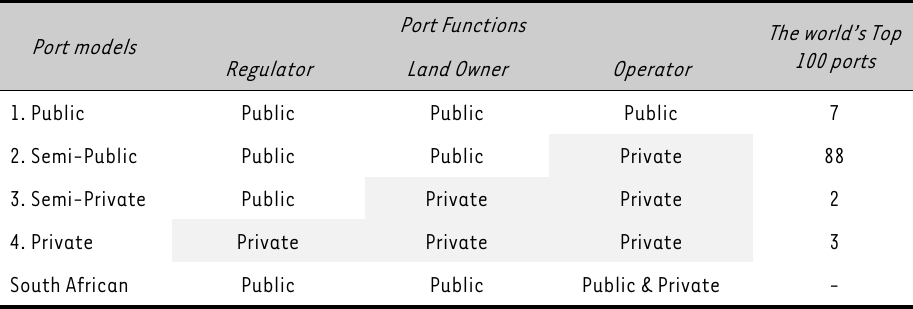
Port Function Matrix Port